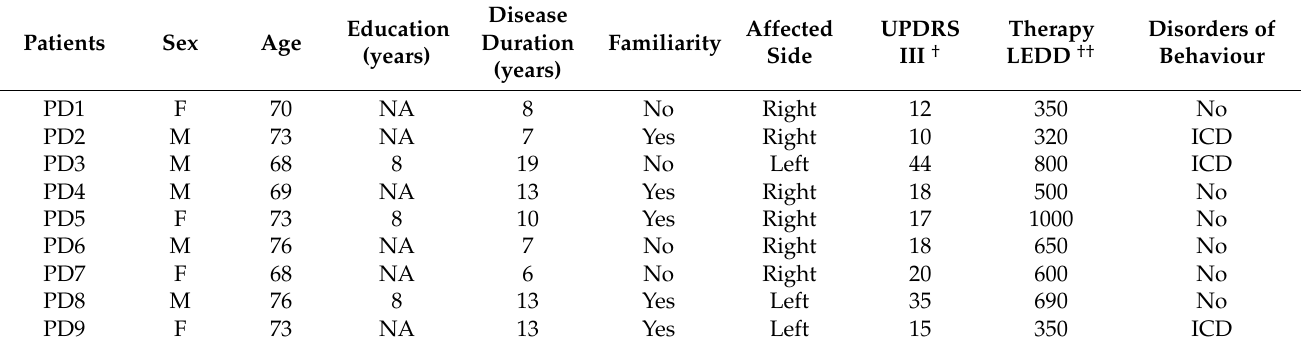
Table 7. Clinical characteristics of PD